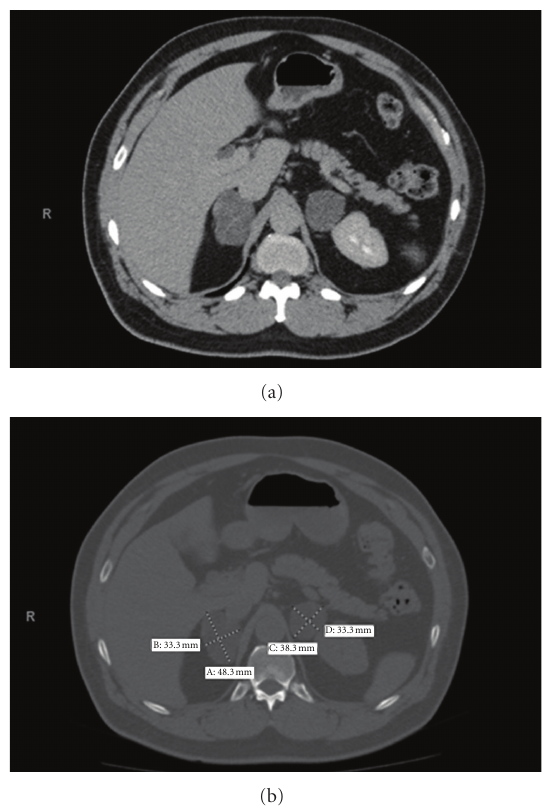
Figure 1: CT scan of abdomen/pelvis with and without contrast as seen during follow-up imaging: lipid-rich adrenal masses bilaterally, right adrenal mass 4.8 × 3.3 cm, previously measured approximately 5.0 × 3.5 cm. Left adrenal mass is 3.8 × 3.3 cm, previously measured 3.7 × 2.9